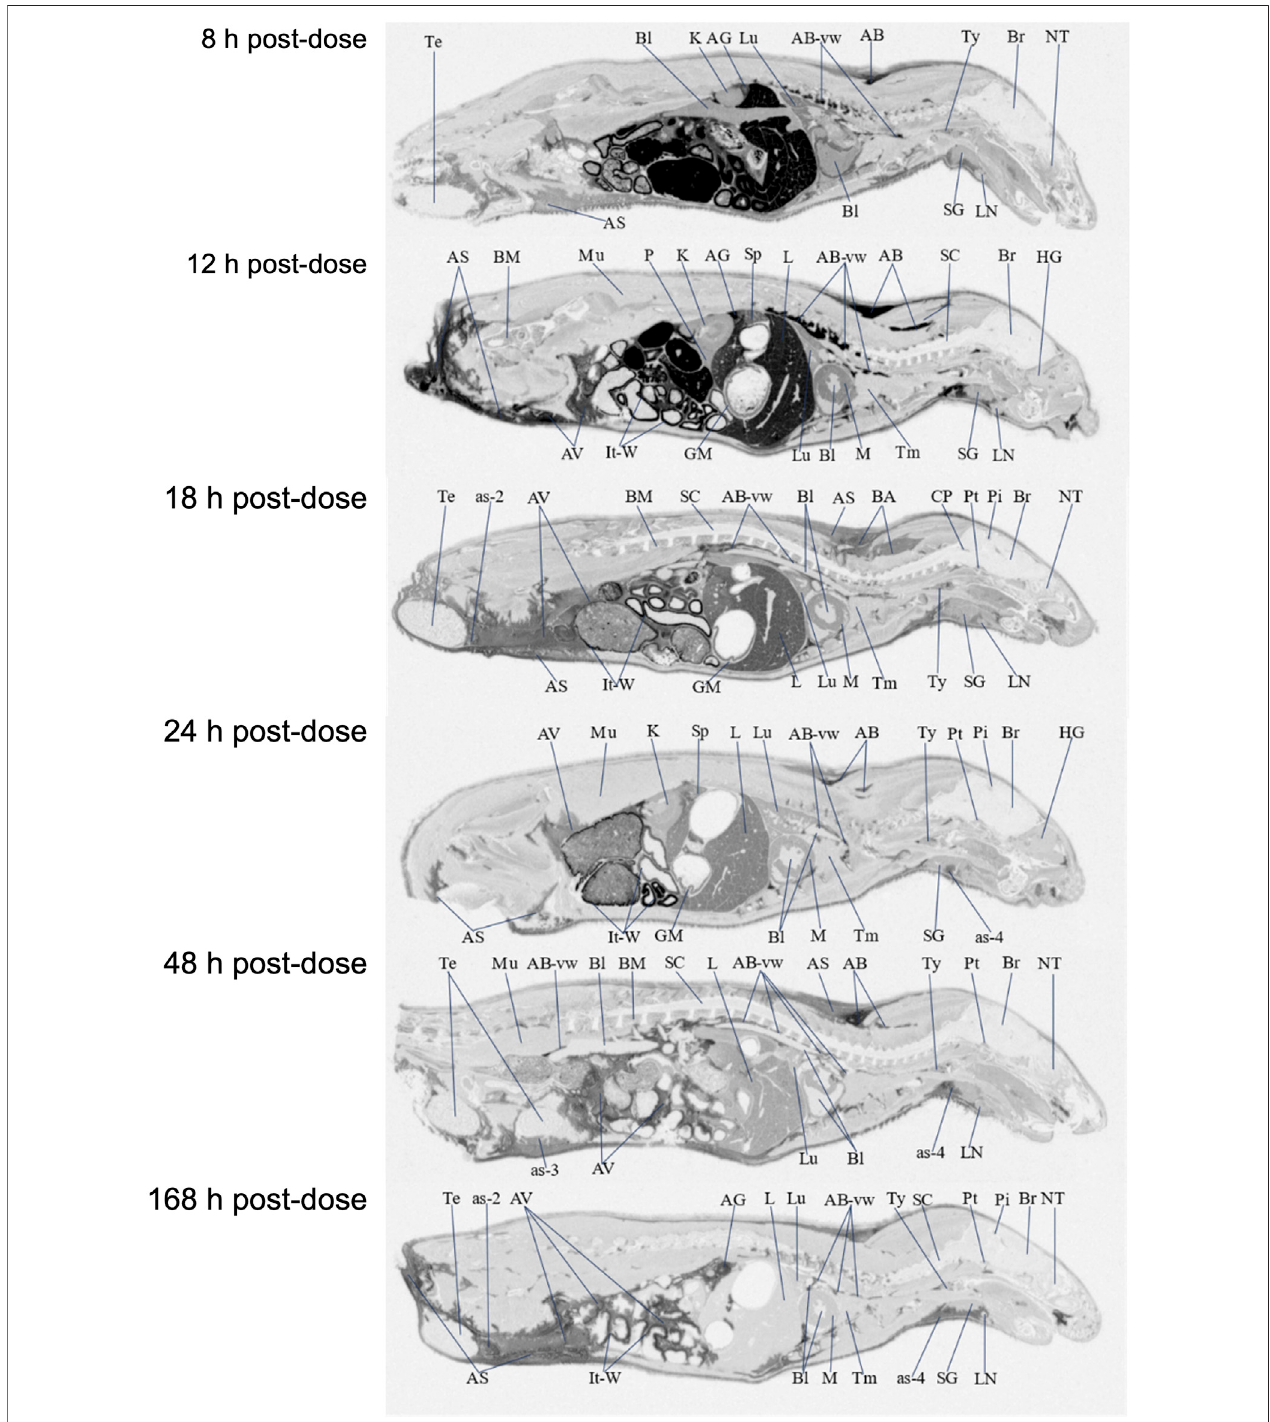
FIGURE 3 | Selected autoradiography images (8, 12, 18, 24, 48, and 168 h post dose) of tissue distribution of in the whole rat body after single-dose oral administrationat100 mg/kg[ 14 C]PPI-1011.Theabbreviationsare:AB,adiposebrown;AS,adiposesubcutaneous;AV,adiposevisceral;AB-vw,adiposebrown:vessel wall; as-2, adipose-soaked:epididymis; as-3, adipose-soaked:testis; as-4, adipose-soaked:salivary gland; AG, adrenal gland; Bl, blood; BM, bone marrow; Br, brain; CP, choroid plexus; GM, gastric mucosa; HG, harderian gland; It-W, intestinal tract wall; K,kidney; L, liver; LN, lymph node;Lu, lung; M, myocardium; Mu,muscle; NT, nasal tubinates; P, pancreas; Pi, pineal gland; Pt, pituitary gland; SC, spinal cord; SG, salivary gland; Sp, spleen; Te, testis; Tm thymus; Ty, thyroid.